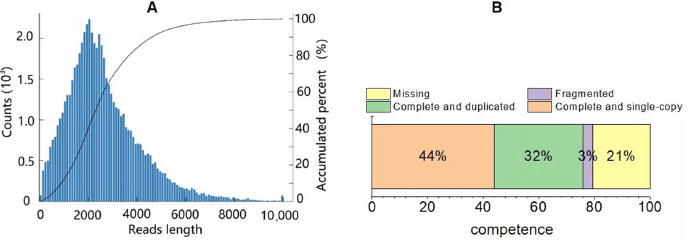
Figure 2. Statistical evaluation of PacBio sequencing. ( A ) length distribution of PacBio sequence. ( B ) Integrity assessment of the redundant transcripts in PacBio sequencing.